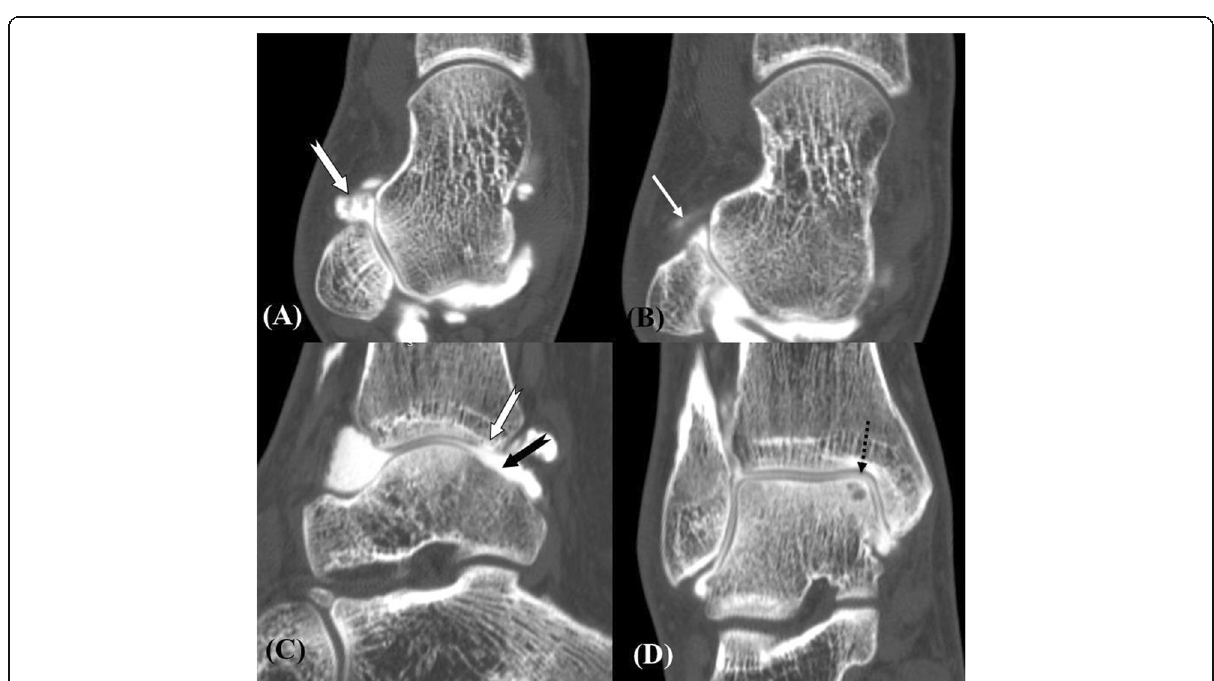
Fig. 5 Acute lateral right ankle pain. He has a history of multiple episodes of lateral ankle sprains; the current episode was lateral sprain. Axial CTA images ( a , b ) show complete tear of the superior band of ATFL (notched arrow) and intact inferior band (arrow). Sagittal CTA ( c ) demonstrates wide loss of hyaline cartilage and subjacent bone plate through the posterior talar dome (black arrow) representing type IV OCL, and the subchondral bone appears flattened, note posterior tibial plafond cartilage defect (white arrow). Coronal CTA ( d ) shows type IIA OCL at the medal talar corner (black